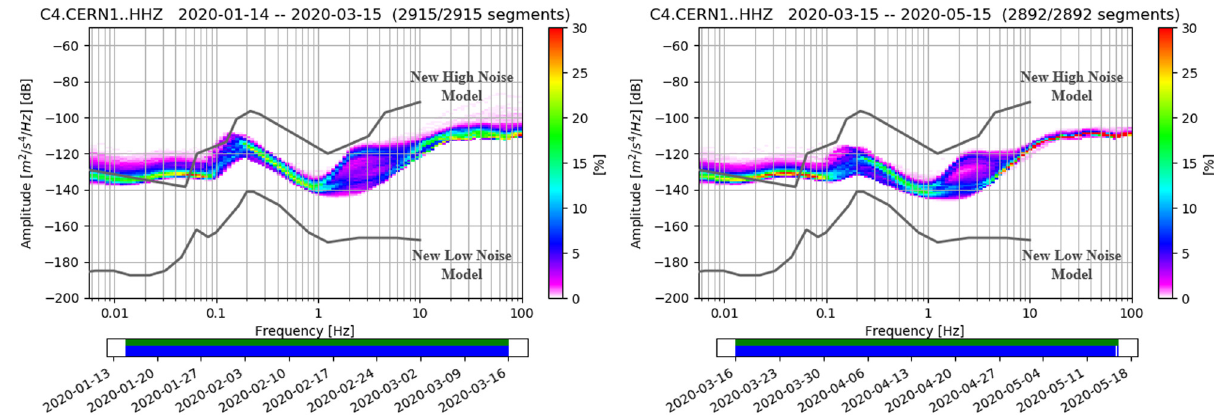
Figure 9: Probabilistic Power Spectral Density of CERN Seismic Station at Point 1 ( ATLAS ) calculated over a period of 2 months before ( left graph ) and 2 months after ( right graph ) the CERN COVID - 19